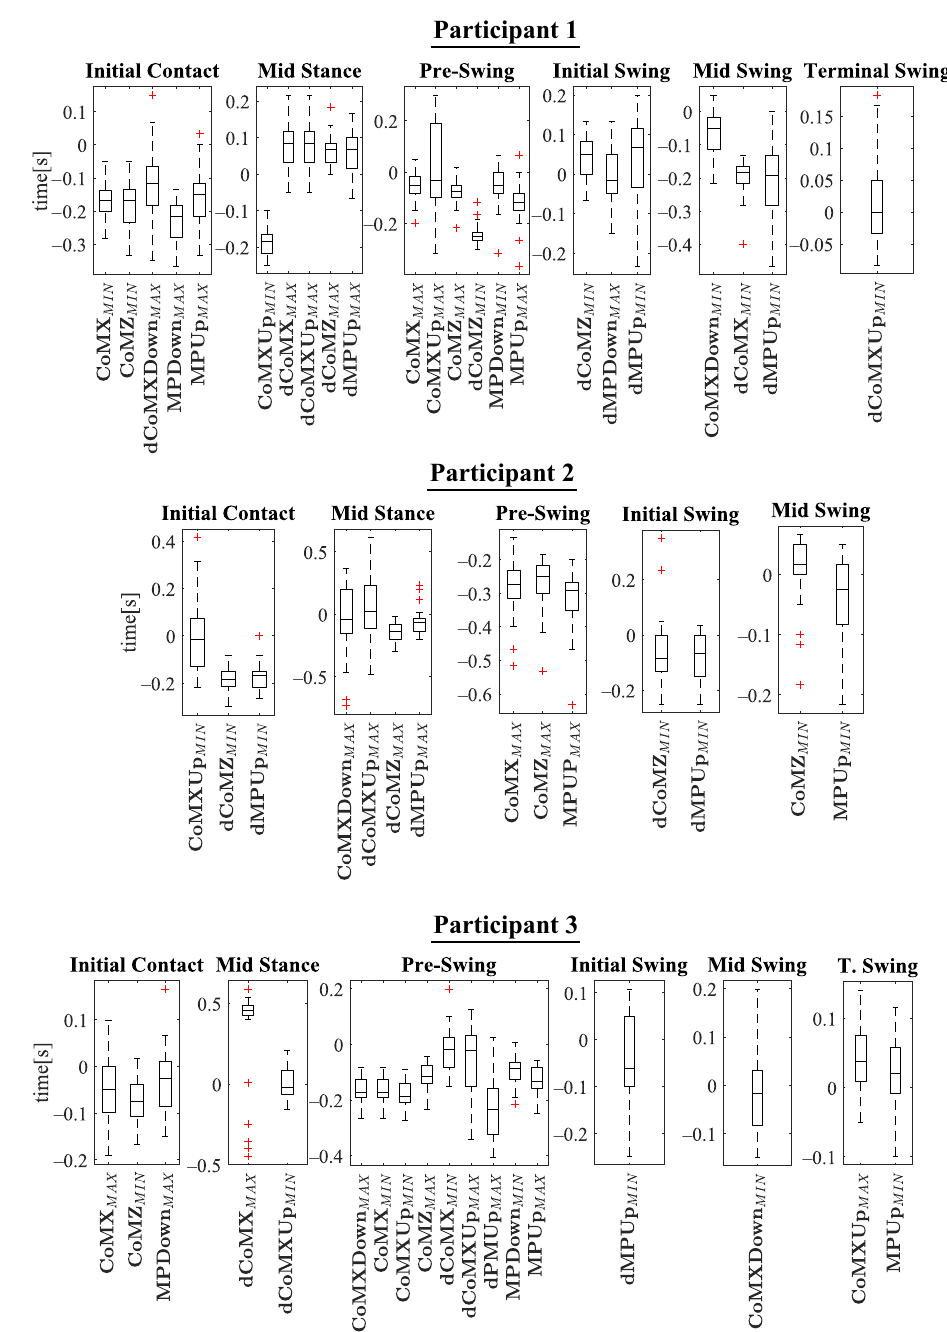
Figure 11. Experimental results for P1–P3. In the y -axis, 0 s is the time corresponding to the phase beginning. Negative time values mean that the event appears before the phase, and positive values that the it occurs after the phase has